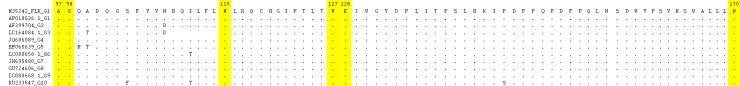
ClustalOmega sequence alignment of different BLV gp51 sequences (genotypes 1 to 10).“-” represents identical aa. The six key amino acids in the interaction are shown in yellow (Ala97, Ser98, His115, Trp127, Glu128 and Asn170).